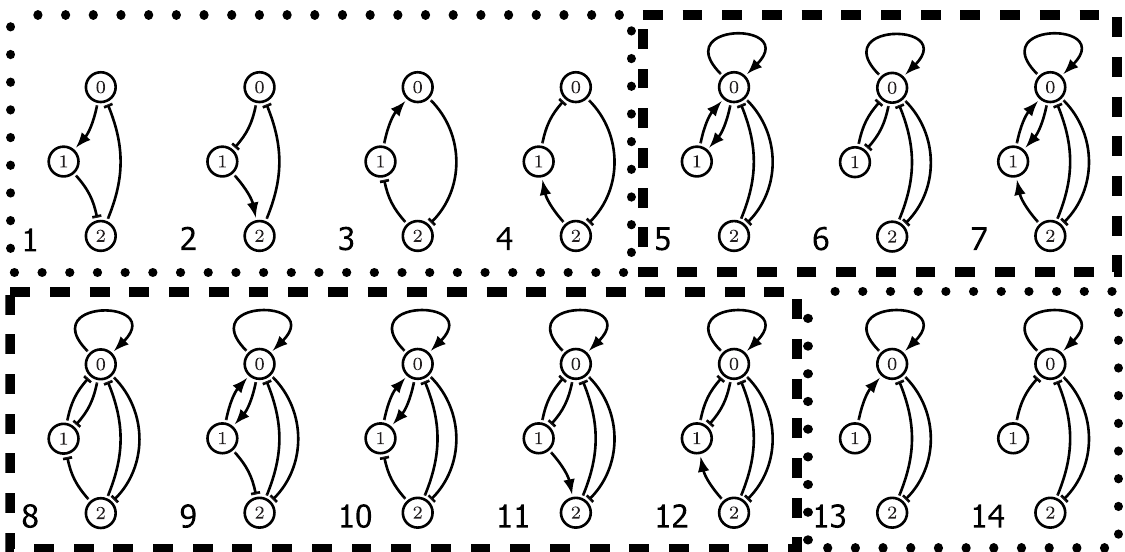
Fig 9. The top fourteen regulatory networks by descending hysteresis score. The six regulatory networks in dotted boxes are fragile, while the eight outlined via the dashed lines are robust. Observe that none of the networks are consistent. Networks 13 and 14 are analogous to networks 13 and 14 of the main paper. The fact that they are fragile recovers observation from [7] that 2-node toggle switch is fragile (see comment in the main text).